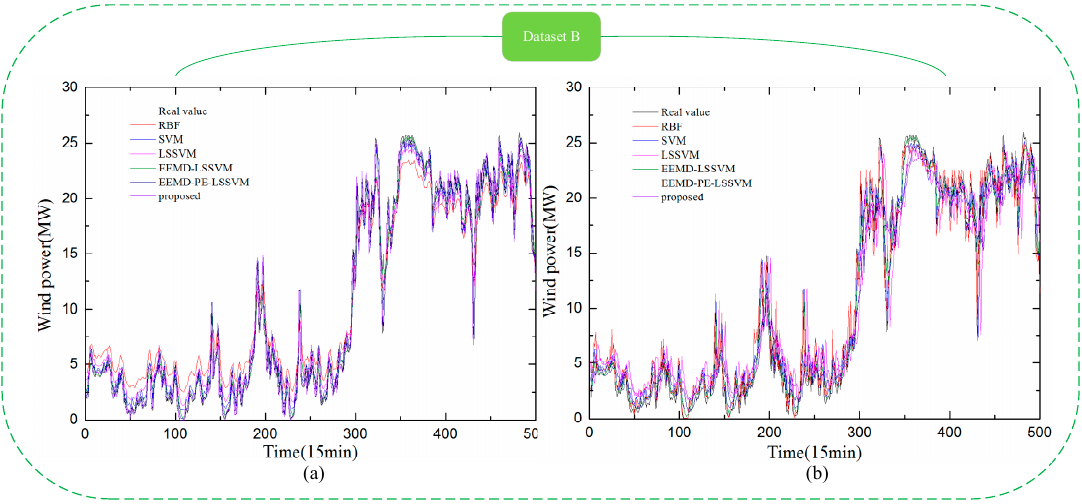
Figure 10. Comparison between the forecast and real values for Dataset B. ( a ) 1-step-ahead result; ( b ) 4-step-ahead result.